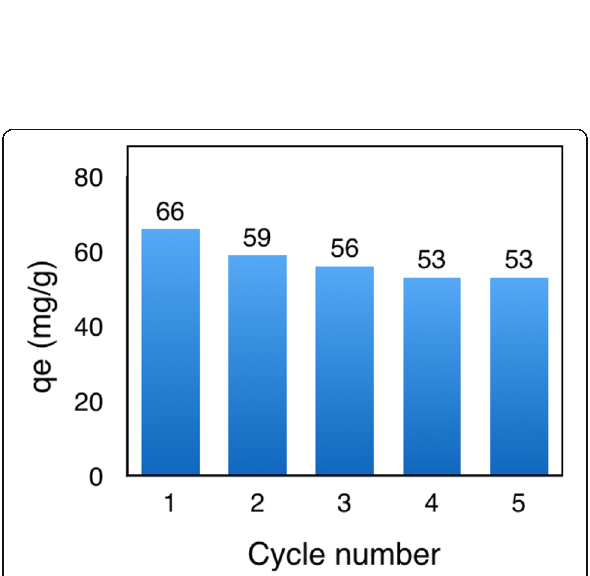
Fig. 6 Recyclability test results involving five cycles of Cu(II) adsorption-desorption for lignosulfonate (LS)-functionalized nGO1-Gel1-LS0.1 composites